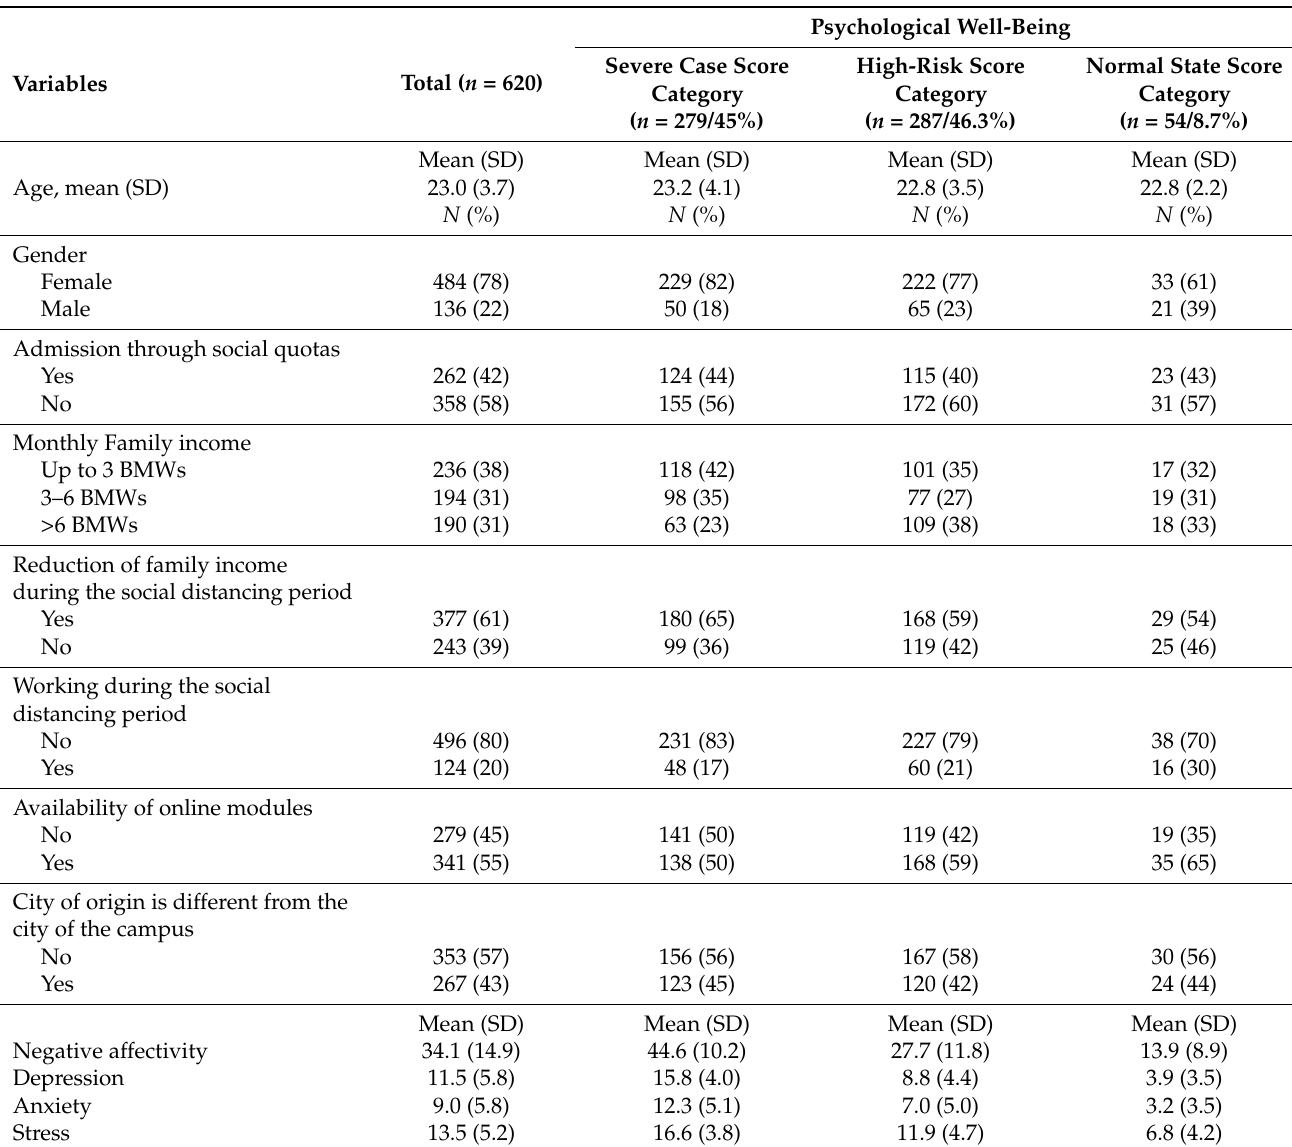
Table 1. Socio-demographics, factors related to disruption of face-to-face classes, and psychosocial factors of the participants: comparison between psychological well-being